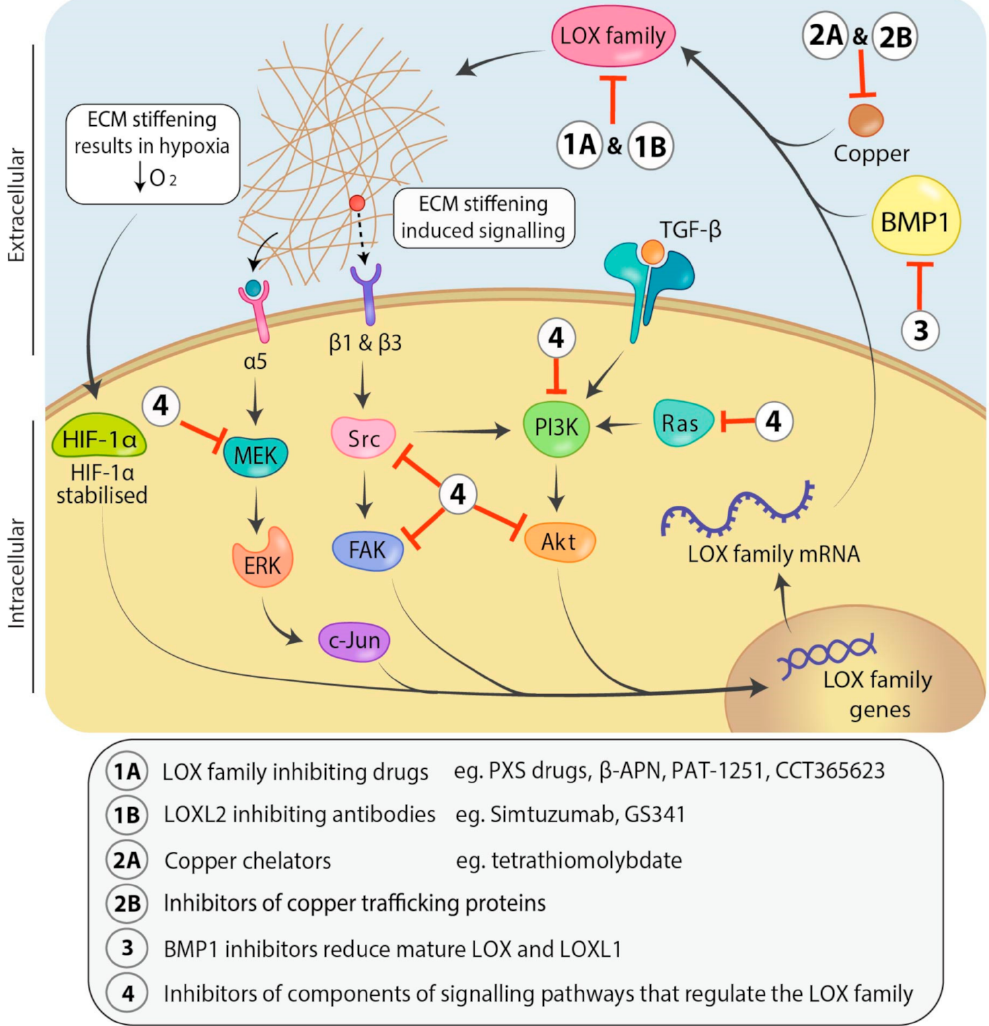
Figure 3. Signaling pathways involved in regulation of and therapeutic avenues for targeting the LOX family. Transform- ing growth factor- β (TGF- β ) regulates LOX family expression through the phosphoinositide 3-kinase/protein kinase B (PI3K/Akt) signaling pathway. LOX family induced ECM stiffening causes mechano-activation of mitogen activated protein kinase (MAPK) and focal adhesion kinase/proto-oncogene tyrosine-protein kinase (FAK/Src) signaling pathways which are also known to upregulate LOX family expression, whilst decreasing oxygen diffusion into the tumour resulting in hypoxia. Hypoxia stabilizes hypoxia-inducible factor 1-alpha (HIF-1 α ) and leads to increased LOX and LOXL2 transcription through binding the hypoxia response elements in their promoters. LOX family members can be inhibited directly with small molecule drugs targeting their active sites (1A) or humanized antibodies that may bind directly or indirectly (allosterically) to the active sites of individual family members (1B). Alternately, LOX family members can be inhibited indirectly through use of copper chelators which remove the critical copper cofactor from the lysyl oxidase active site (2A), inhibitors of copper trafficking proteins (2B), inhibitors of bone morphogenetic protein 1 (BMP1) to prevent LOX and LOXL1 proenzyme processing and activation (3) or inhibitors of the components of the pathways involved in LOX family regulation (4). Abbreviations: Mitogen-activated protein kinase kinase (MEK), extracellular signal-regulated kinase (ERK), messenger RNA